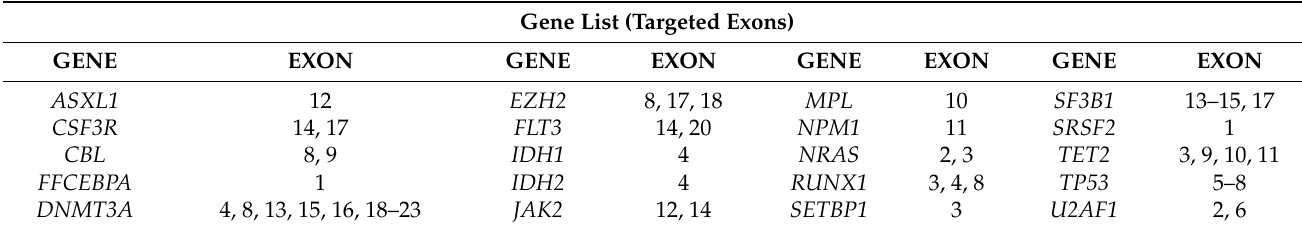
Table 1. ClearSeq AML HS